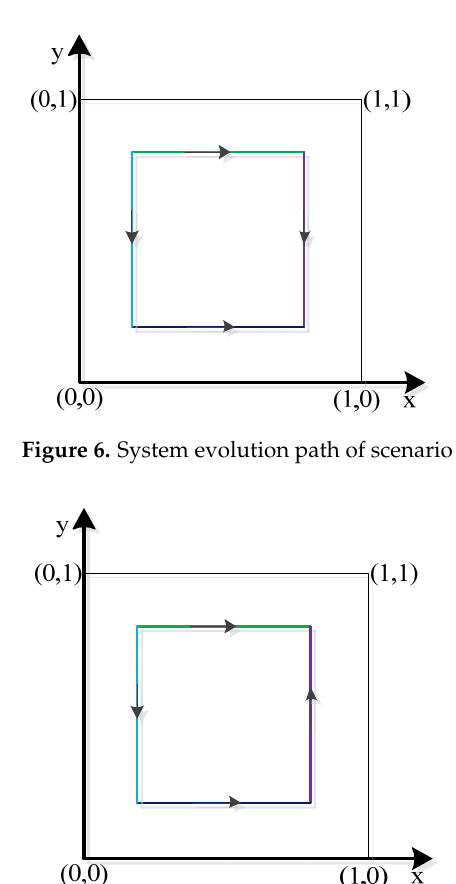
Figure 8. System evolution path of scenario 4. 5.2. Model Parameter Analysis